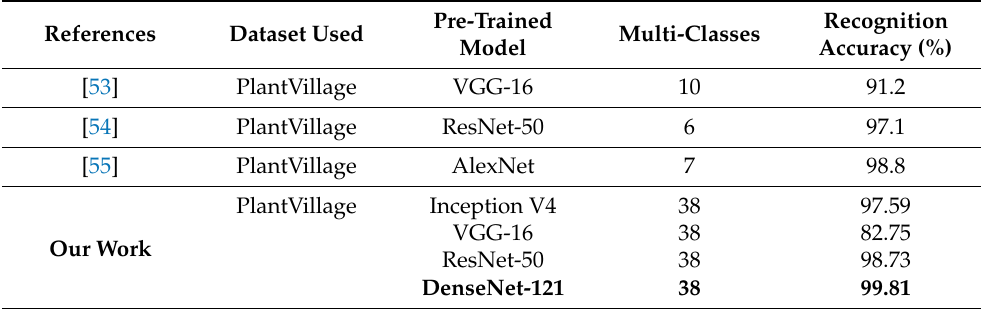
Table 6. Comparison with state-of-the-art transfer learning